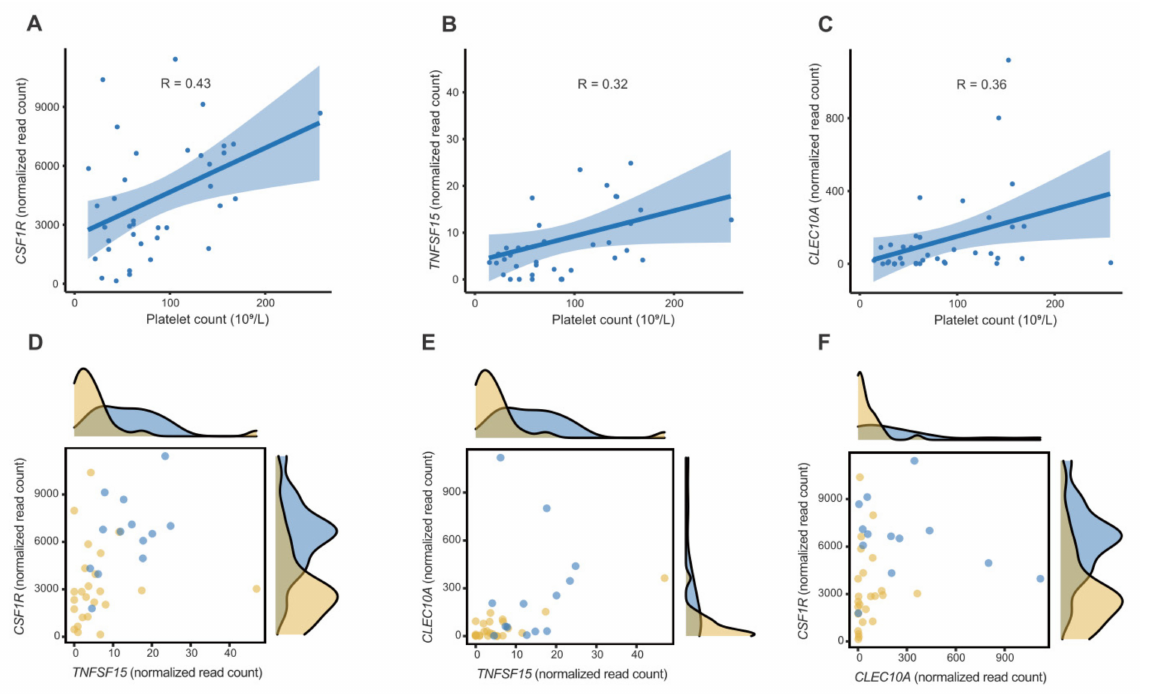
Figure 4. Association between the RNA expression of genes ( CSF1R , TNFSF15, and CLEC10A ) and platelet counts in normal karyotype acute myeloid leukemia (NK-AML). ( A – C ) The expression levels of the genes had a positive correlation with the platelet counts in NK-AML. ( D – F ) Scatter plot with marginal histograms of the prevalence of platelet-decreased NK-AML (PD-AML; light orange) and platelet-not-decreased NK-AML (PND-AML; blue) in gene expression